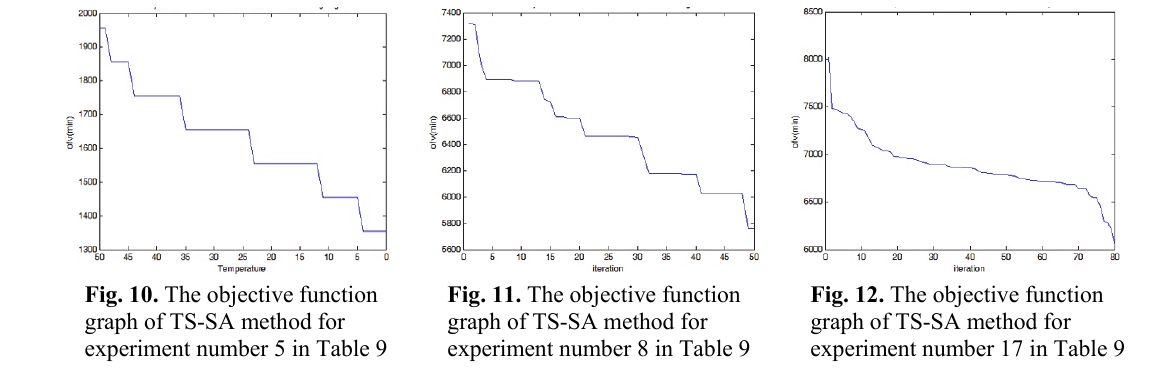
Results of solving numerical examples from the literature for CCDCMS model e ca l S